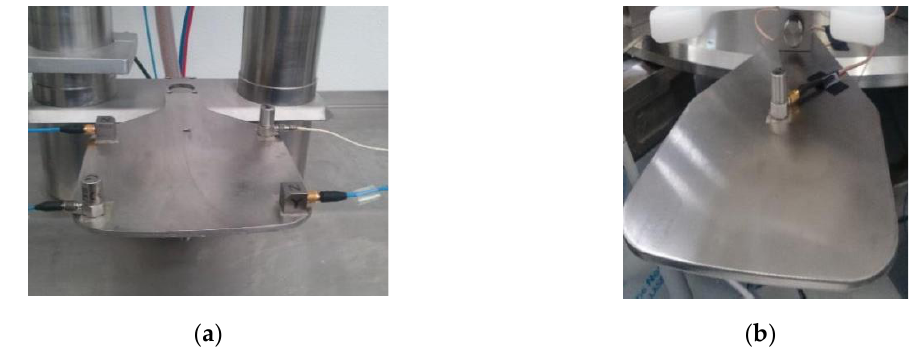
Figure 3. Accelerometers setup: ( a ) first test campaign on the test-bench (two three-axial and two mono-axial); ( b ) second test campaign on the weight filler (one mono-axial).